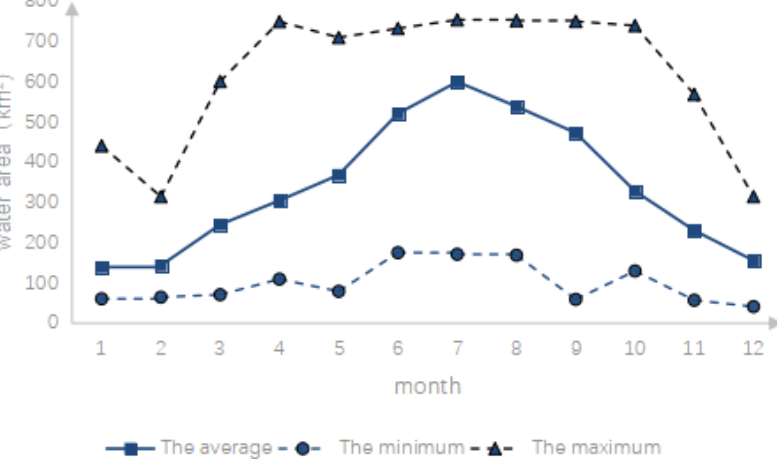
Figure 2. Lunar surface area curve of seasonal lakes area.